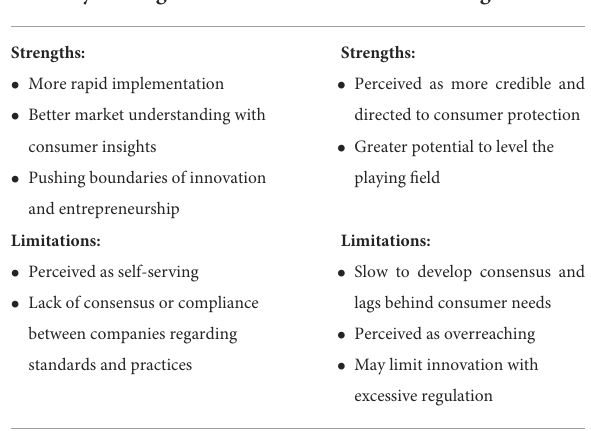
TABLE 2 Strengths and limitations of industry self-regulation and government regulation of precision nutrition. Industry self-regulation